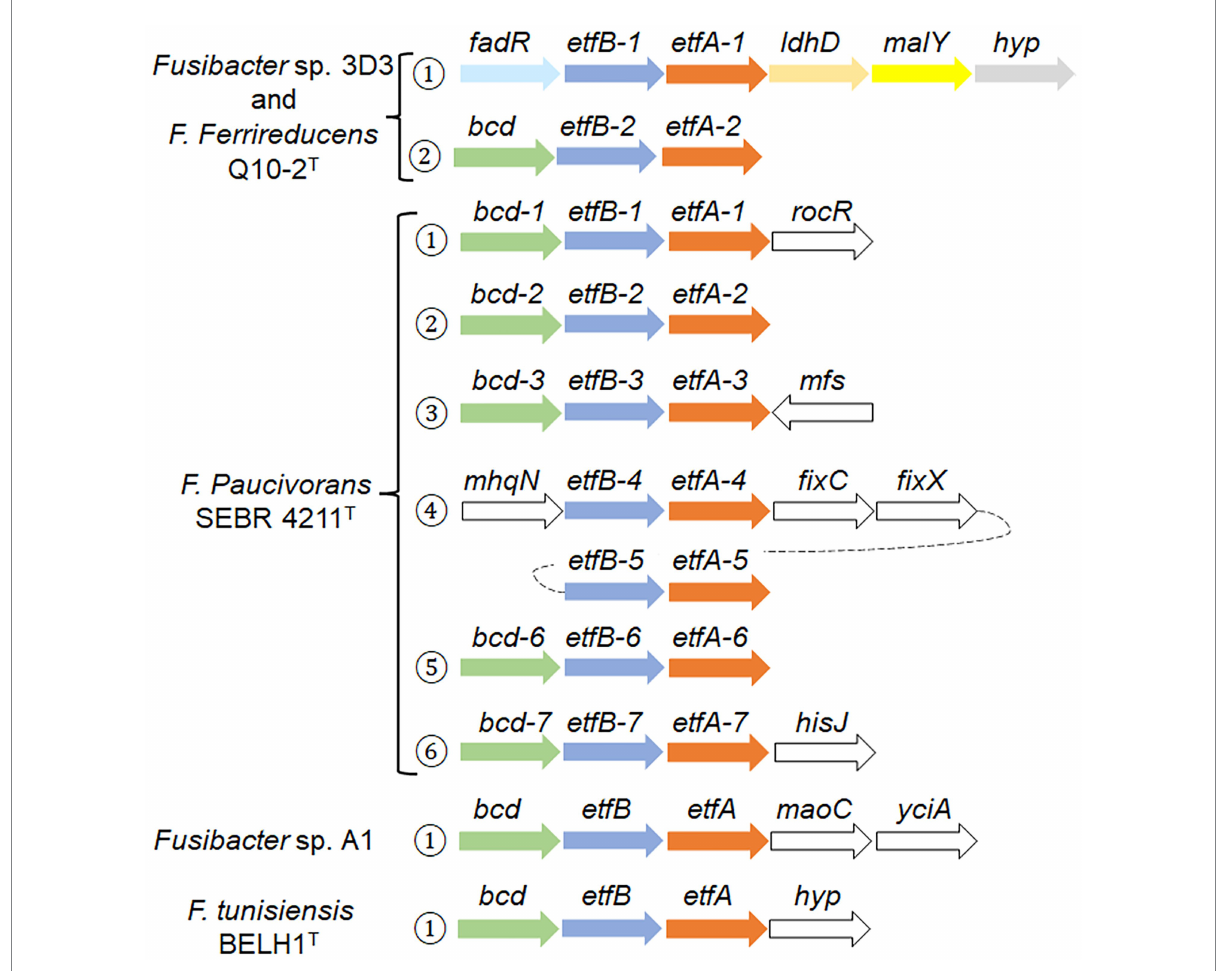
FIGURE 5 Genomic context of etf related genes in Fusibacter . Numbers in circles indicate the occurrence of the etf copies. The arrows represent the orientation of the gene (size is not at scale), and the same colors indicate homology, except white. The gene products are described in the text and the gene product accession numbers are listed in Supplementary Table